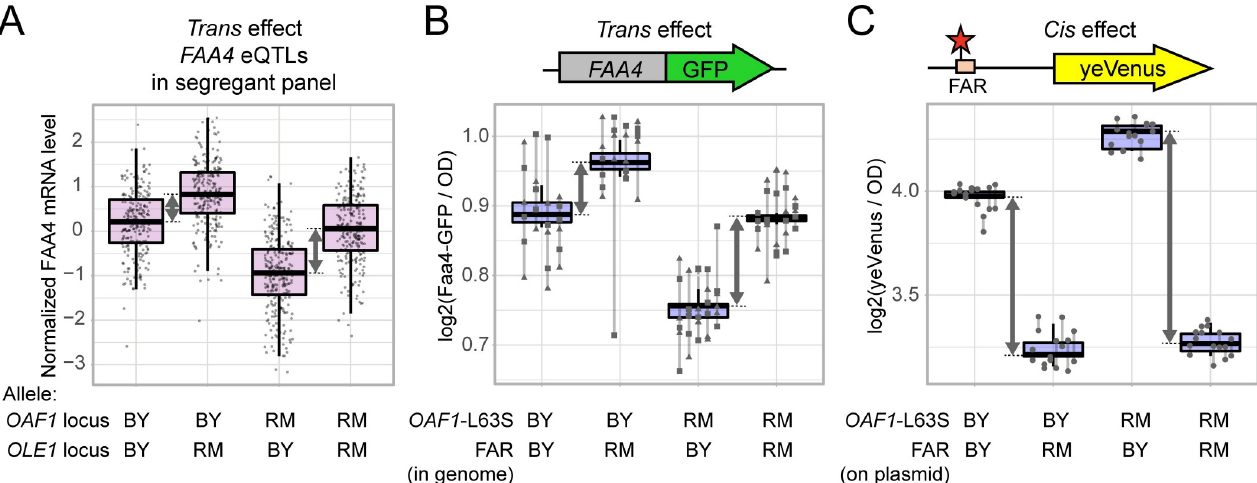
Fig 7. Nonadditive genetic interaction between the OAF1 and OLE1 causal variants. A. Data from [12] show levels of FAA4 mRNA in 1,012 BY/RM segregants, divided into four groups depending on their genotypes at OAF1 and OLE1 . Note the slightly larger difference between OLE1 alleles in segregants that carry the RM allele compared to the BY allele at OAF1 . B. Faa4-GFP fluorescence levels in strains in the BY background engineered to carry the BY or RM allele at OAF1(L63S) and OLE1(FAR) . C. yeVenus fluorescence levels for strains in the BY background engineered to carry the BY or RM allele at OAF1(L63S) and the OLE1(FAR) promoter driving yeVenus expression on a plasmid. The difference between OLE1 alleles in segregants (in A) or strains (in B and C) that carry the RM allele compared to the BY allele at OAF1 are highlighted by gray arrows.